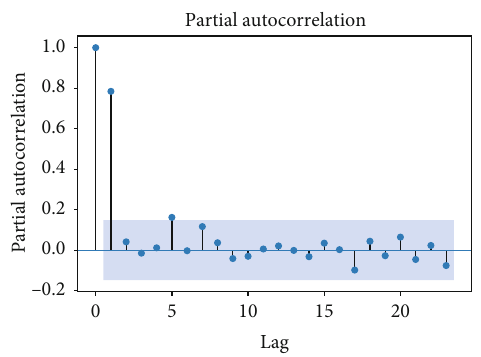
Figure 15: Partial autocorrelation for oil